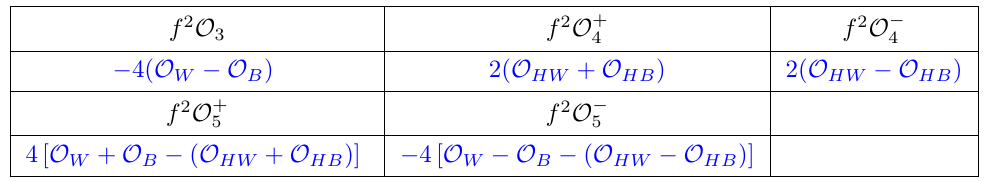
Table 8. Matching of the eq.